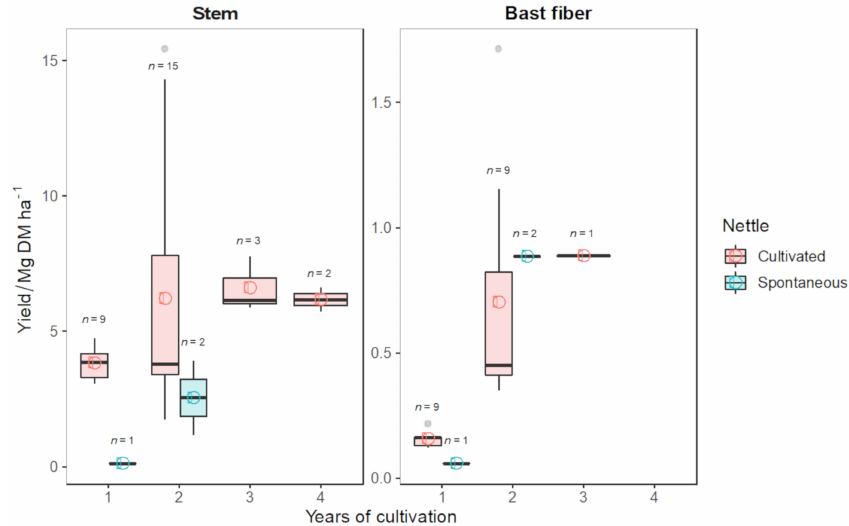
Figure 7. Nettle stem and bast fiber yield (Mg DM ha − 1 ) as affected by years of cultivation in spontaneous and cultivated nettle. Points within boxplots are mean values, while the thick line in the boxplot represents the median value. Data have been obtained for studies collected in